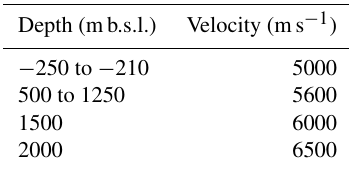
Table 3. The 1D migration velocity